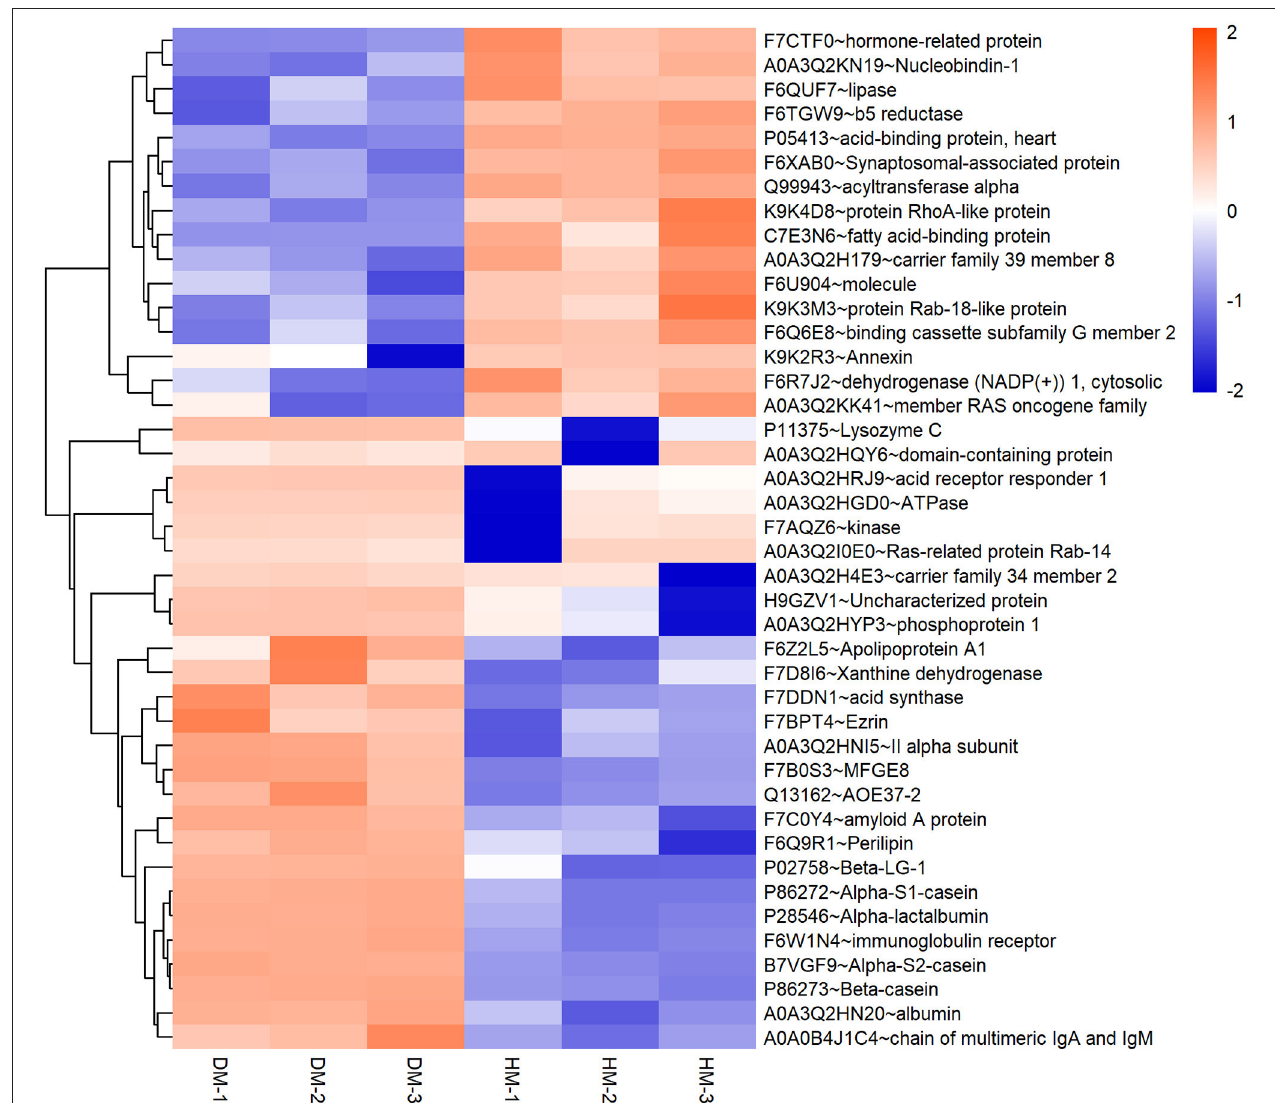
FIGURE 2 | Hierarchical clustering of DEP in DM and HM group. Bar color represents a logarithmic scale from − 2 to 2. DEP, differentially expressed proteins; DM, donkey milk. HM,: human